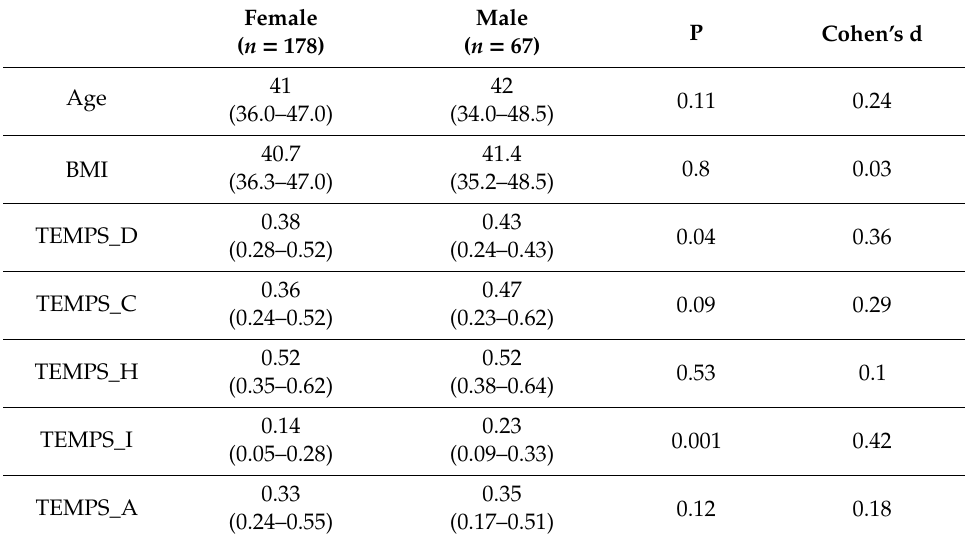
Table 1. Age, body mass index (BMI) and results on the TEMPS-A scale in study participants. Data are presented as medians, and 25th and 75th